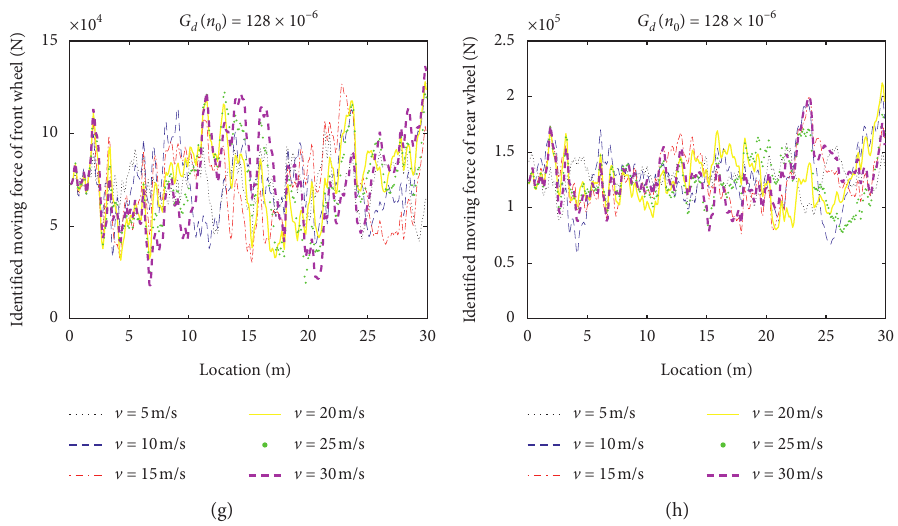
Figure 19: Moving force at different velocities and different pavement roughness.